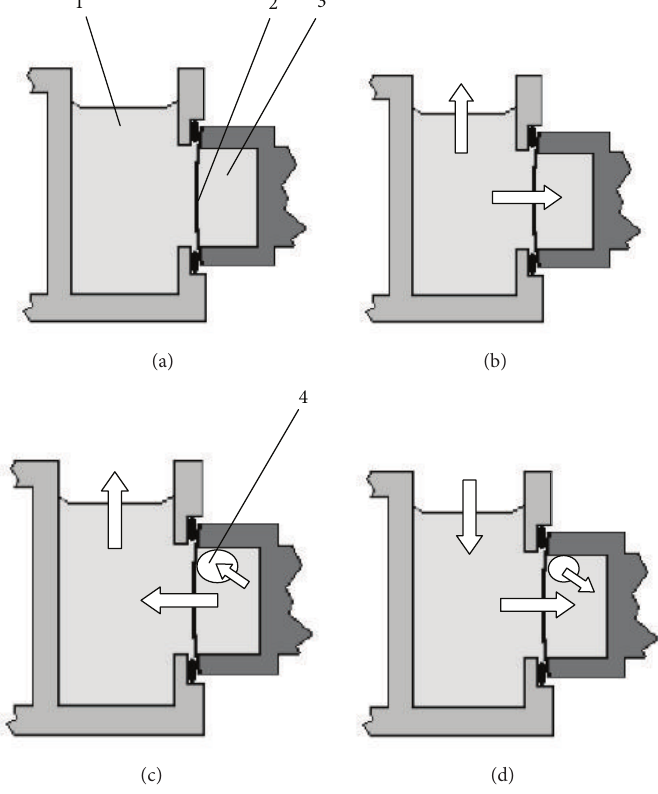
Figure 7: The proposed mechanism of gas bubbles formation in the electrolyte at periodic heating/cooling of the oxygen sensor (diffusion fluxes of gases are shown by arrows): (a) is initial state of the system at room temperature, (b) is rapid heating of the incubation medium, (c) is heating of the oxygen sensor after thermostabilization of the incubation medium, and (d) is cooling of the systems up to room temperature after work. (1) is the incubation medium, (2) is membrane, (3) is sensor electrolyte, and (4) is gas bubble. The main reason for the formation of bubbles (4) is supersaturation of the electrolyte (3) of the oxygen sensor during the heating (b, c) with insufficient rate of gas exchange with a medium (1) limited by a permeability of membrane (2). At the same time, even the low permeability of the membrane allows gases to return into the electrolyte from the medium under cooling (d). For this reason, bubbles are not dissolved completely under